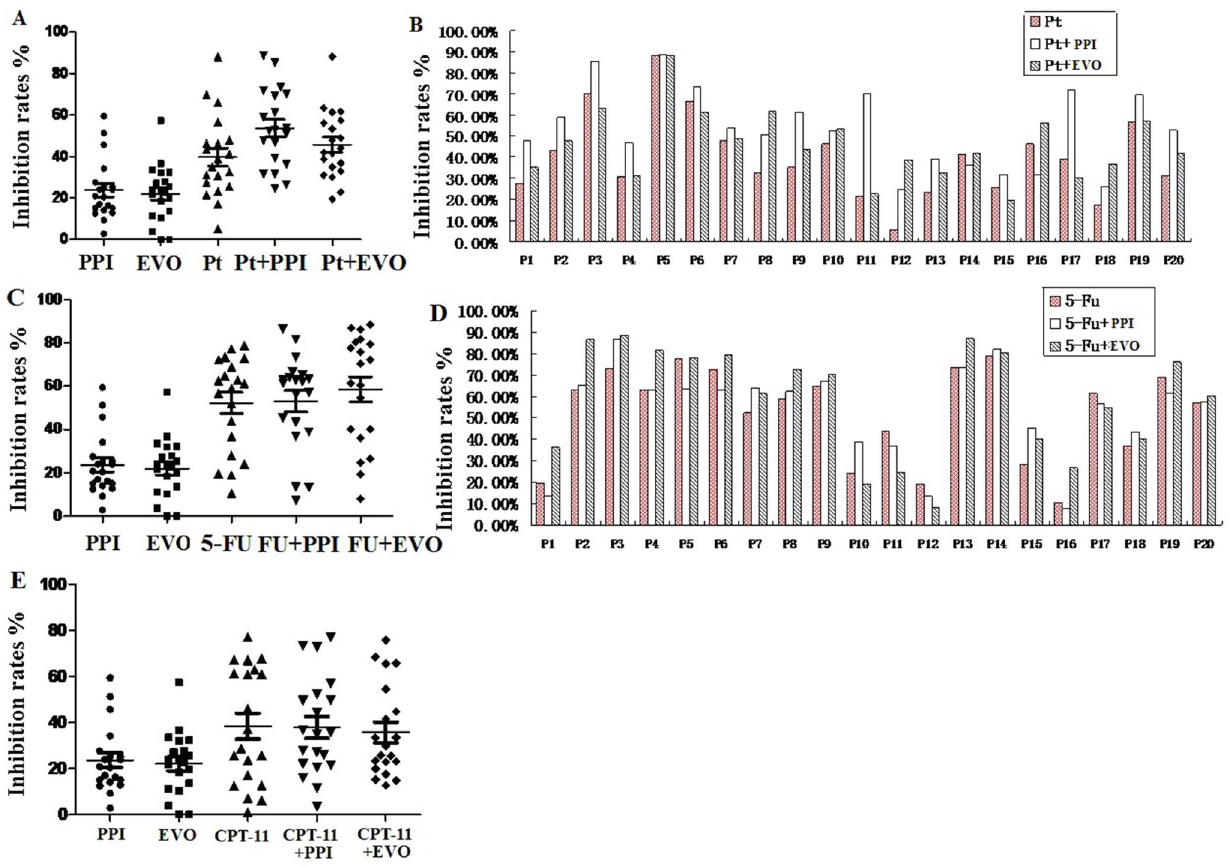
Figure 5. The inhibition rates of different agents or their combination on freshly-removed gastric cancer. A, combination Pt with PPI or EVO exhibits higher anticancer efficiency than any agents used alone (n=20); B, the inhibition rates of every 20 samples after combination with Pt and PPI or EVO compared with Pt alone; C, combination 5-FU with PPI or EVO exhibits higher anticancer efficiency than any agents used alone (n=20); D, the inhibition rates of every 20 samples after combination with 5-FU and PPI or EVO compared with 5-FU alone; E, combined with PPI or EVO, the inhibition rates of CPT-11 were not significant improved (n=20).